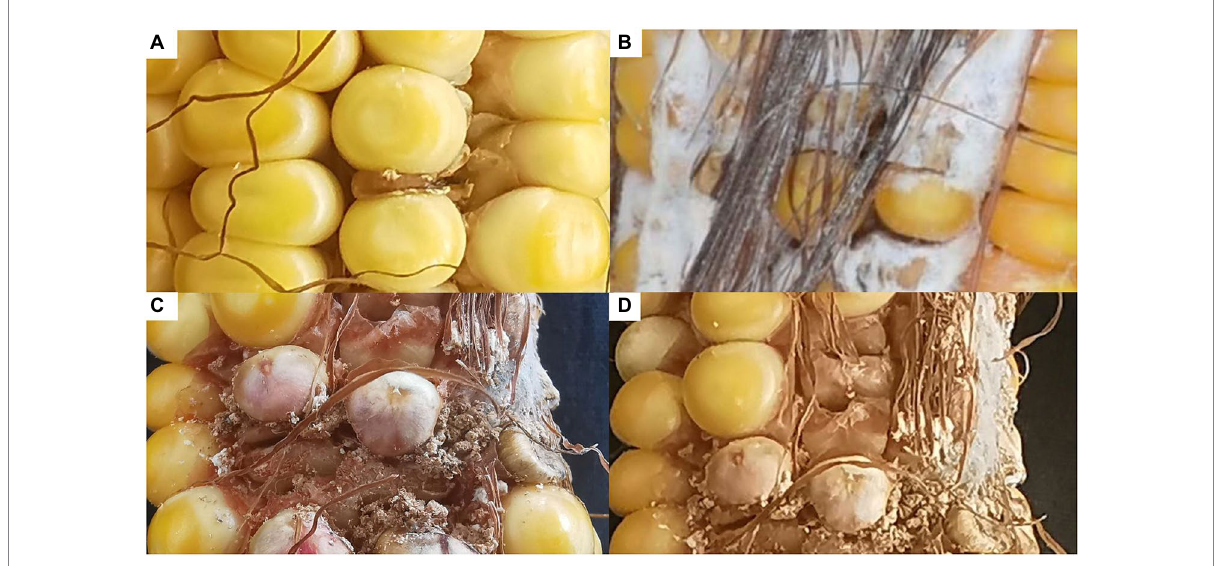
FIGURE 3 Incidence and severity of FER among CL171 and the gene-silenced materials. (A) CL171; (B) CL171-1; (C) CL171-2; (D) CL171-3.